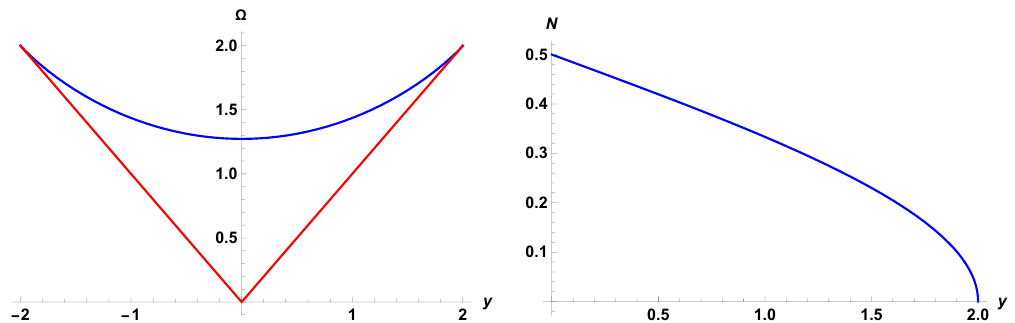
Figure 1 . The limiting Young diagram shape Ω ( y ) and density of boxes N ( y ) for the Plancherel